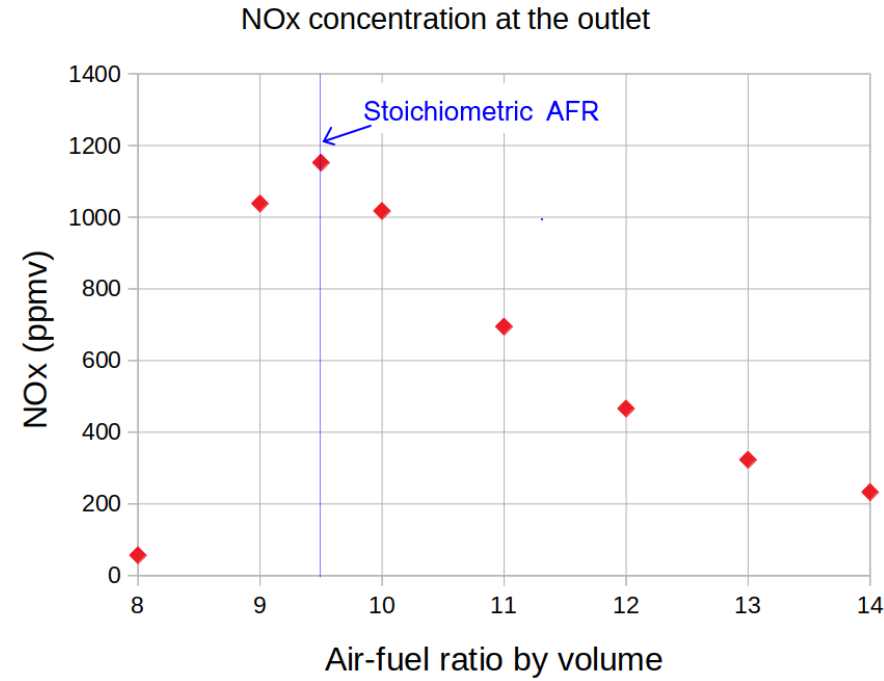
Figure 13. Average thermal NOx concentration at the outlet of the kiln for different